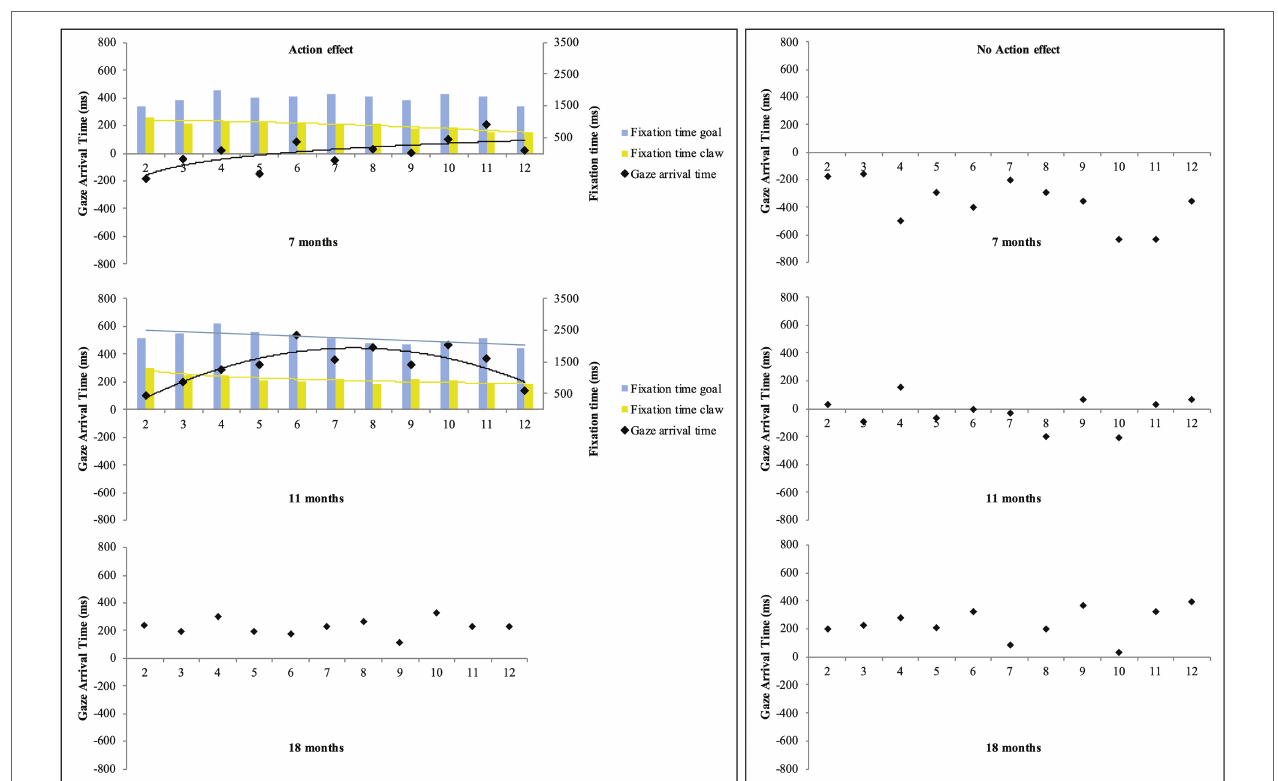
FIGURE 3 | Mean gaze-arrival times (black dots) and fixation times on the goal AOI (blue bars) and the claw AOI (yellow bars) across trials 2–12 for the 7-, 11-, and 18-month-olds in the action-effect and no-action-effect condition. Positive and negative values represent mean gaze-arrival times before and after the claw arrived at the goal AOI. The curves represent the significant fit for the regression functions (linear, logarithmic, or quadratic) with most explained